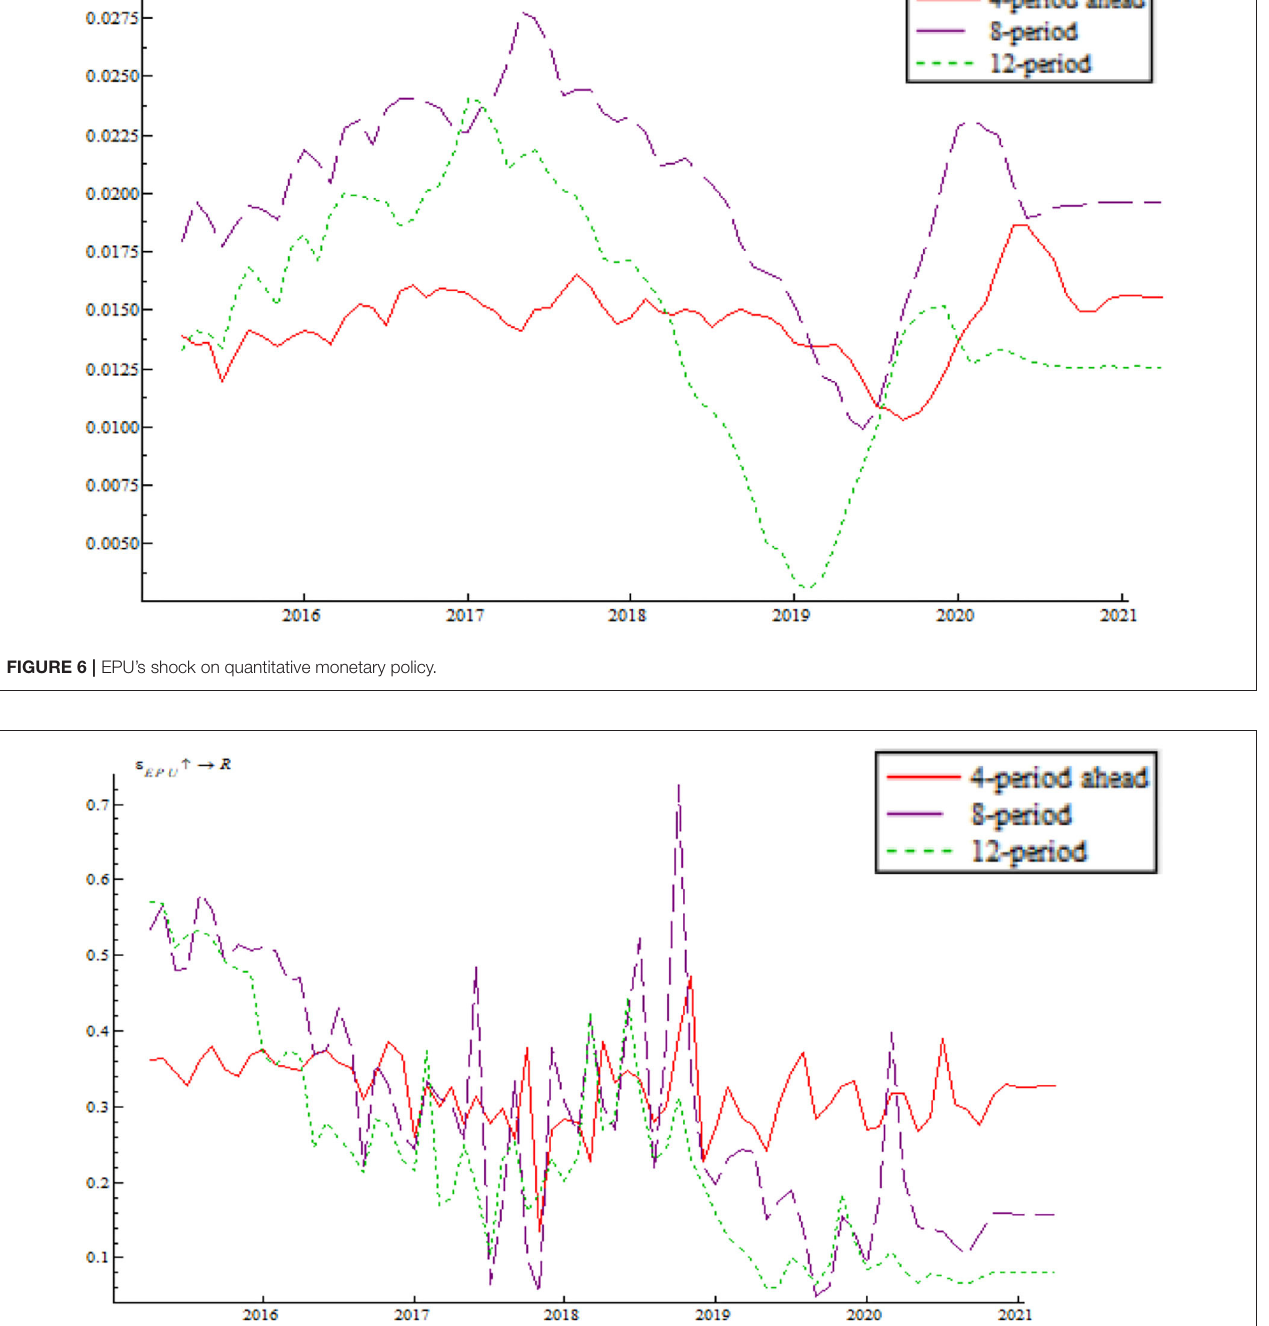
FIGURE 7 | EPU’s shock on price-based monetary